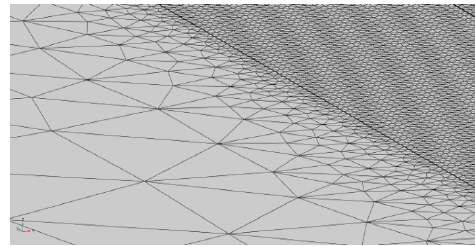
Figure 5. Mesh detail at the interface with the central slot.